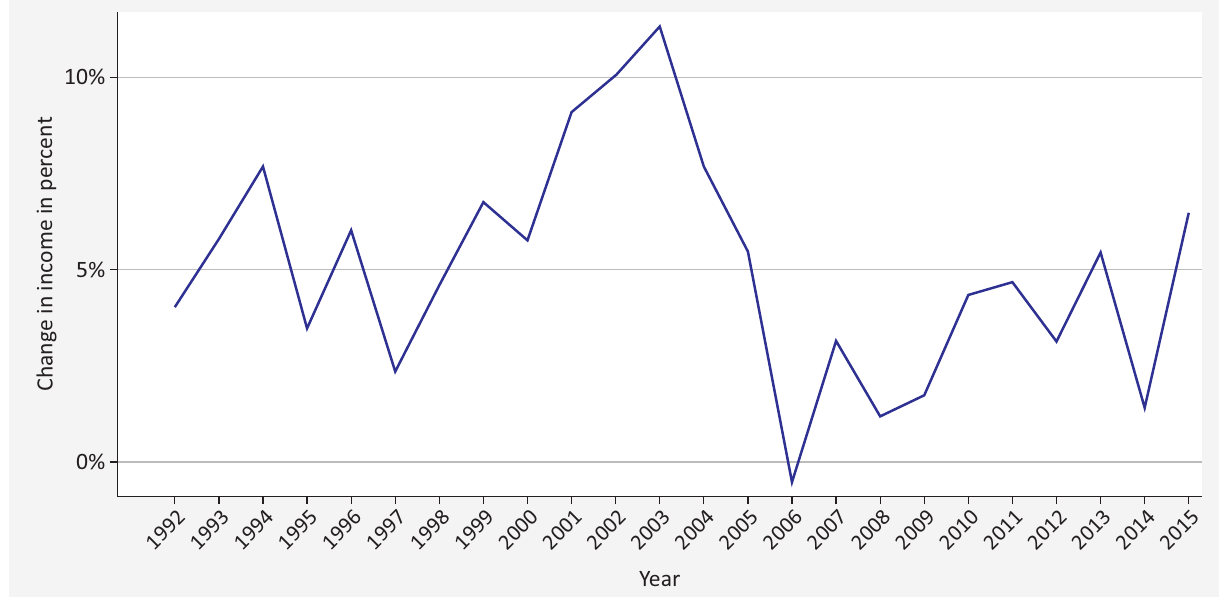
Figure 2. Average relative wage development of professional education and IVET only certificate holders (compared to the year 1991).